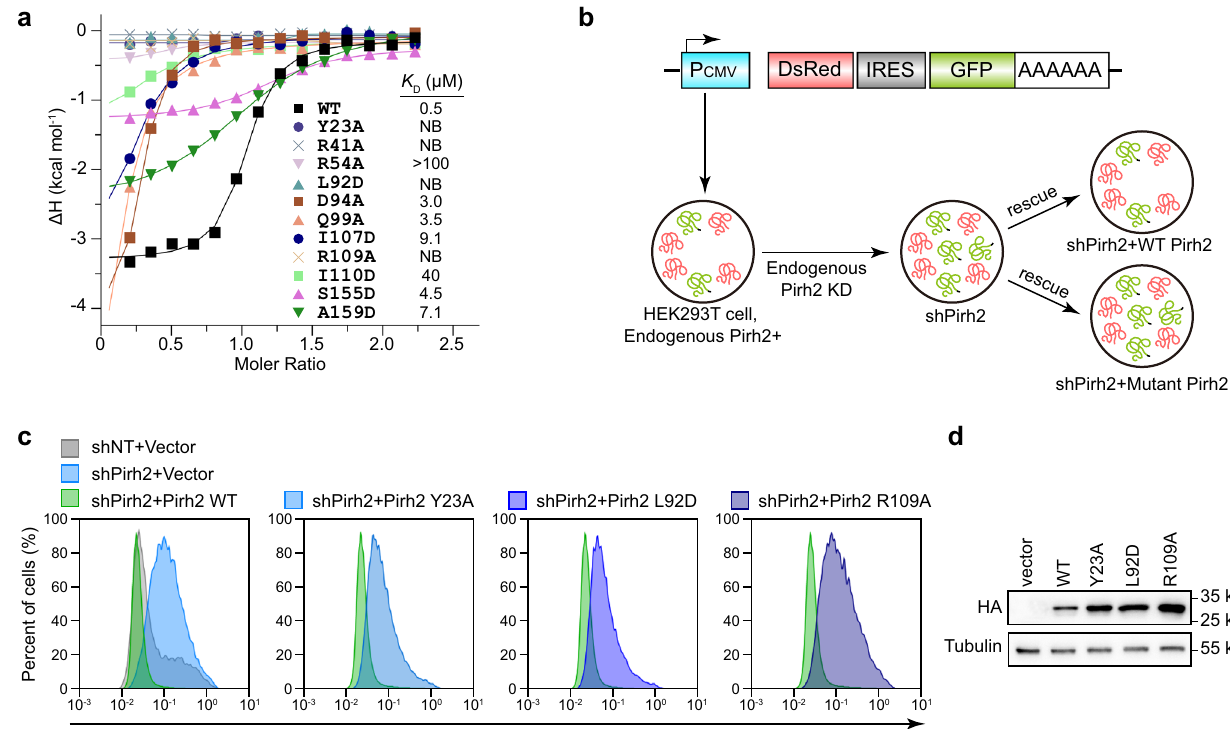
Fig. 4 | Mutagenesis analysis of Pirh2 for Ala6/C-degron binding. a ITC fi tting curvesofwild-type(WT)andmutantPirh2titratedwiththeAla6/C-degronpeptide. Thecorrespondingmutantproteinsandbindingaf fi nities( K D )areindicated.NB,no detectablebindingunderourexperimentalconditions. b Schematicrepresentation of the GPS assay. P CMV , cytomegalovirus promoter; DsRed, Discosoma sp. red fl uorescent protein; IERS, internal ribosome entry site; GFP, green fl uorescent protein. c Stability analysis of GFP-fused Ala6/C-degron in endogenous Pirh2